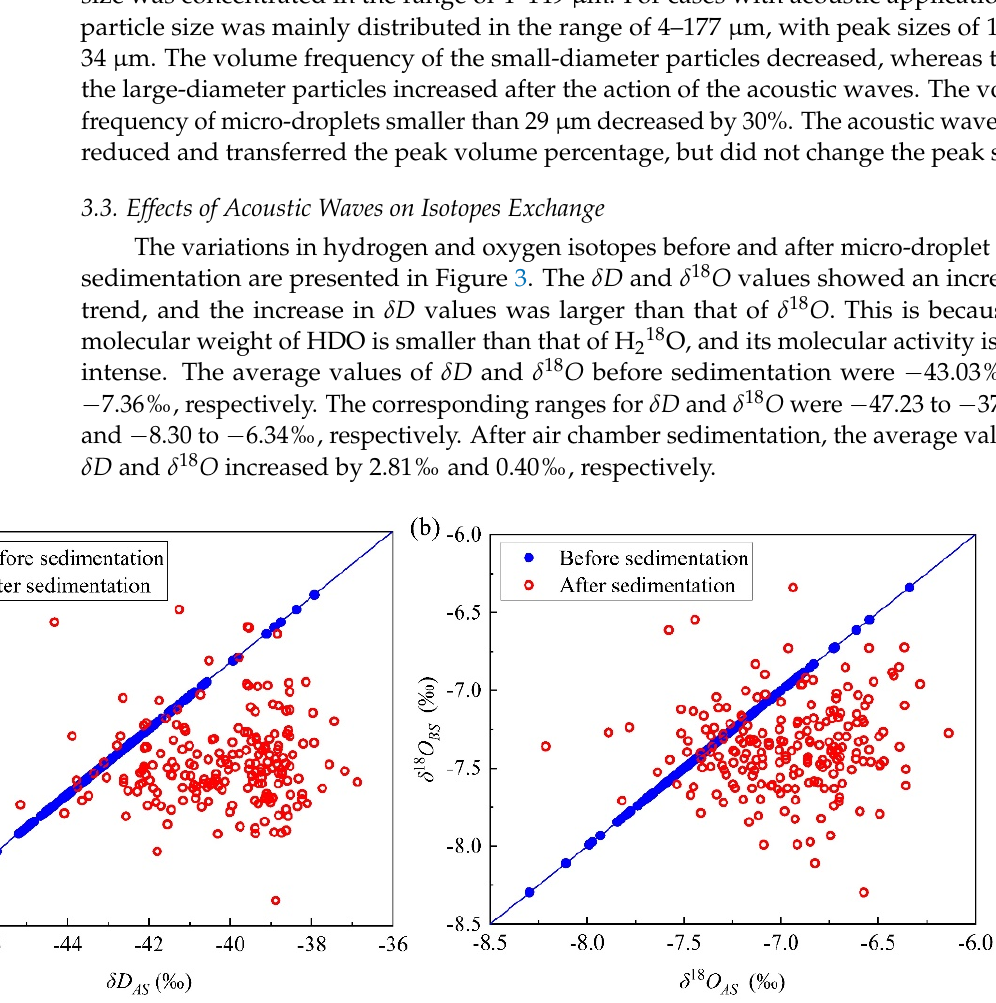
Figure 3. ( a ) Relationships of δ D before and after micro-droplet groups’ settlement and ( b ) relationships of δ 18 O before and after settlement.